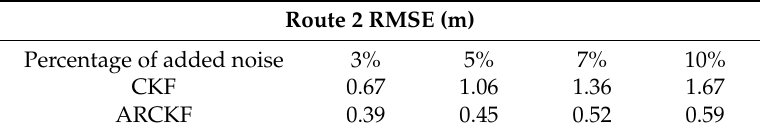
Table 6. RMSE of positioning with noise added to UWB range measurements.